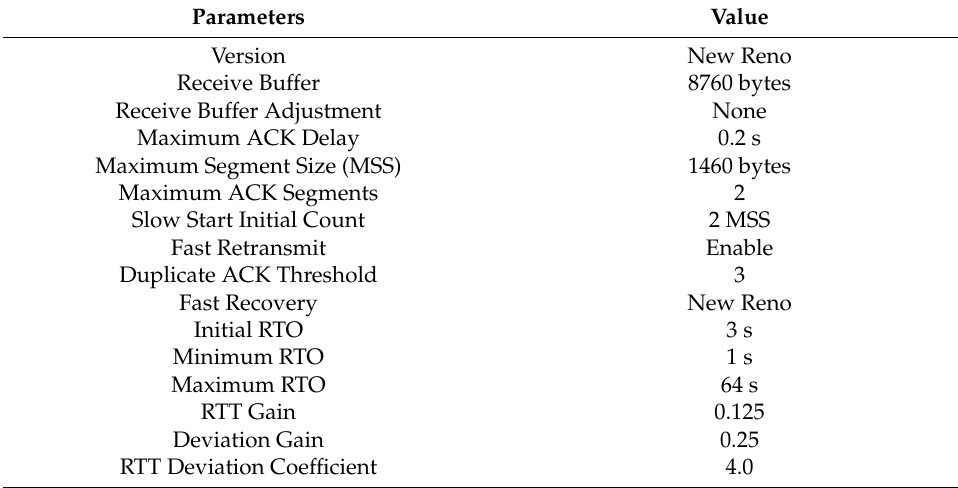
Table 4. Main TCP parameters used in the